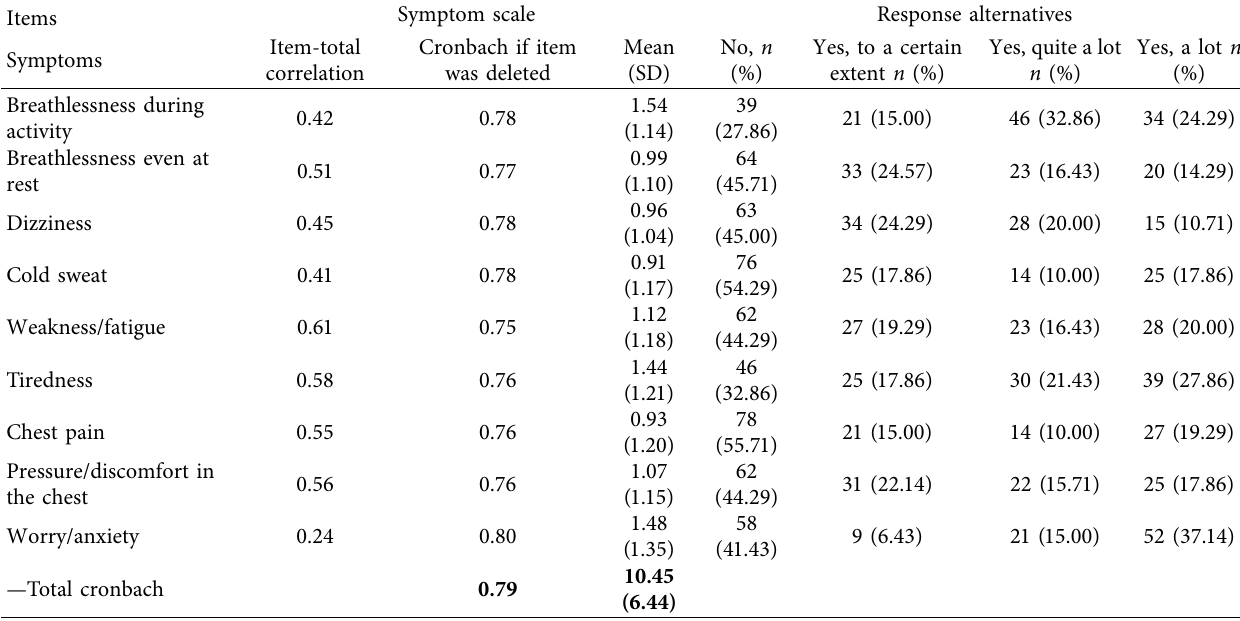
Table 2: Data quality and item-total correlations for the ASTA-Br-symptom scale.